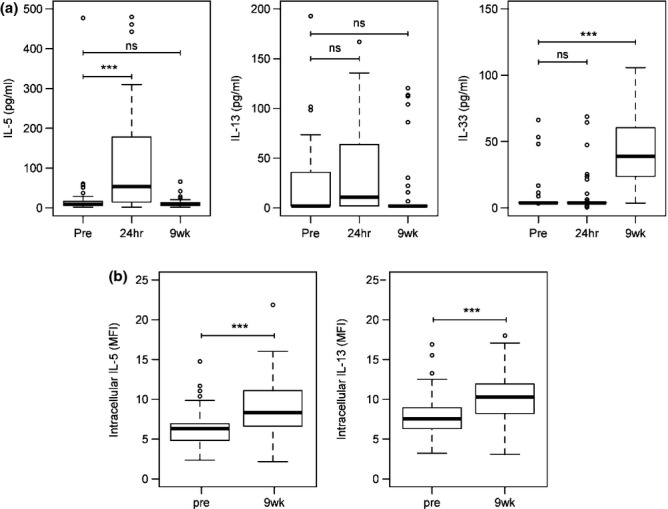
Circulating levels of IL-5, IL-13 and IL-33 and eosinophil intracellular IL-5 and IL-13. (a) Shown are boxplots, representing the cohort's median and interquartile ranges, of the circulating levels of IL-5, IL-13 and IL-33 measured pretreatment, 24 h and 9 weeks post-treatment. ***P < 0·001, ns, not significant by Wilcoxon test. (b) Shown are boxplots, representing the cohort's median and interquartile ranges, of the median fluorescence intensity of intracellular IL-5 and IL-13 in eosinophils collected pretreatment and 9 weeks post-treatment. ***P < 0·001 by Wilcoxon test.